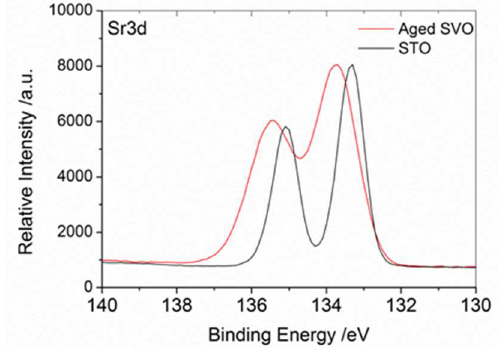
Fig. 1. Sr3d spectral regions of both STO (black) and air- exposed SVO (red) recorded by regular XPS on PLD thin